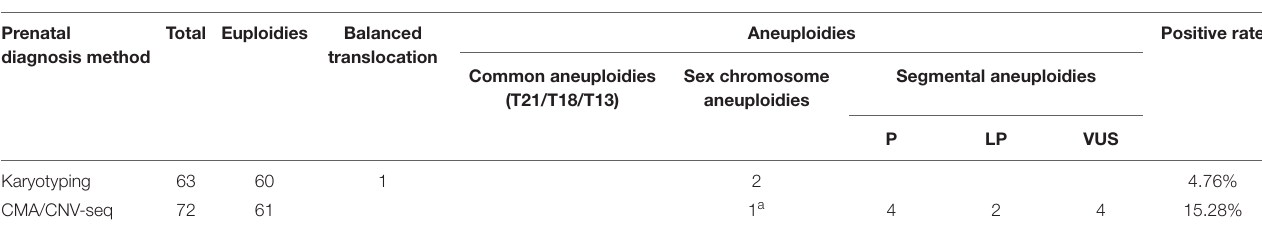
TABLE 5 | Selection and results of prenatal diagnosis